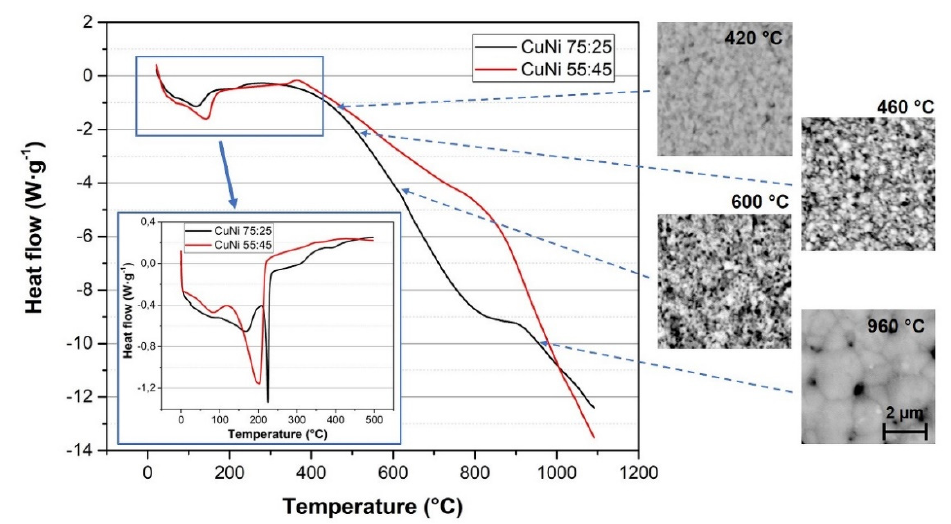
Figure 2. DSC analysis in N 2 of prepared copper-nickel inks and results of test firings.